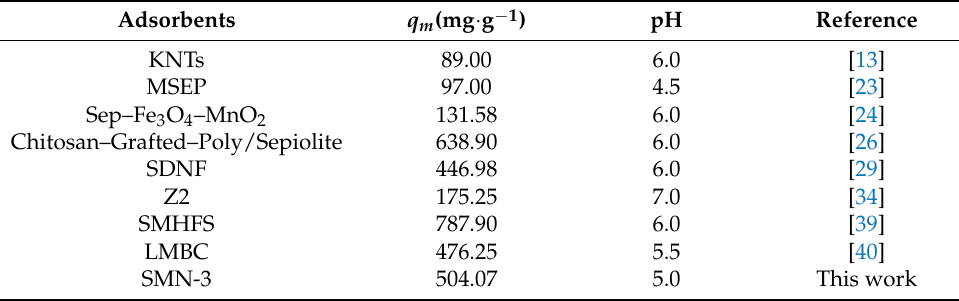
Table 3. Comparison of the adsorption capacities of various adsorbents for